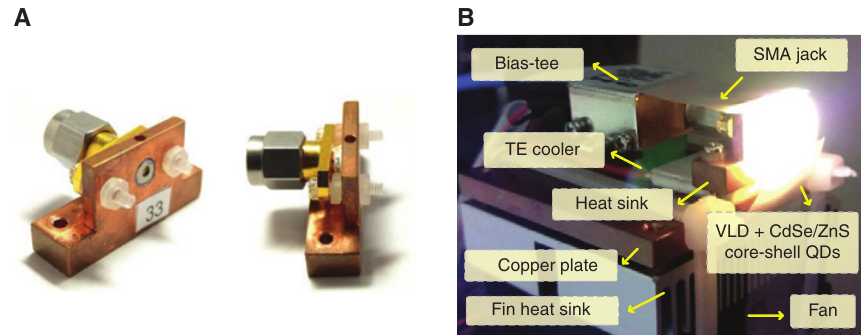
Figure 1: The VLD based lighting and transmitting source for the white-light VLC. Photographs of (A) VLD on copper plate and (B) VLD + CdSe/ZnS core-shell-QD white-light